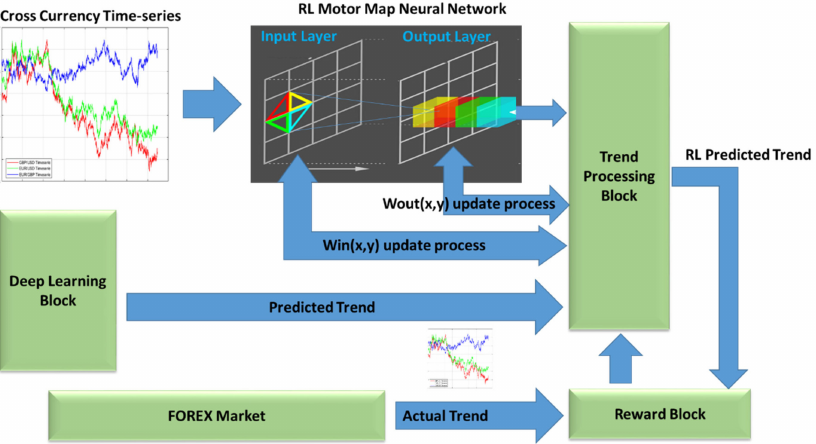
Figure 8. Proposed reinforcement learning block to correct the predicted trend made by the deep learning